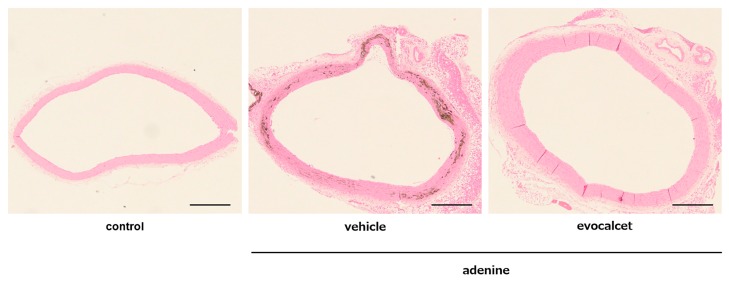
Representative von Kossa staining of the CKD rat aorta.Thoracic aortas from control rats and CKD rats with SHPT induced by adenine were subjected to von Kossa staining. Scale bar, 500 μm. (A) Control; (B) vehicle-treated CKD; (C) evocalcet-treated CKD.